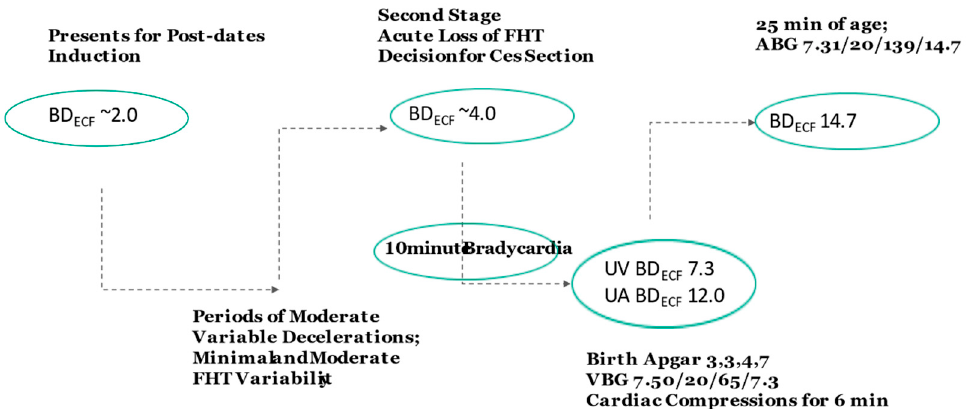
Figure 1. Flow Chart of Case 3. Values within ovals are determined by analysis (see